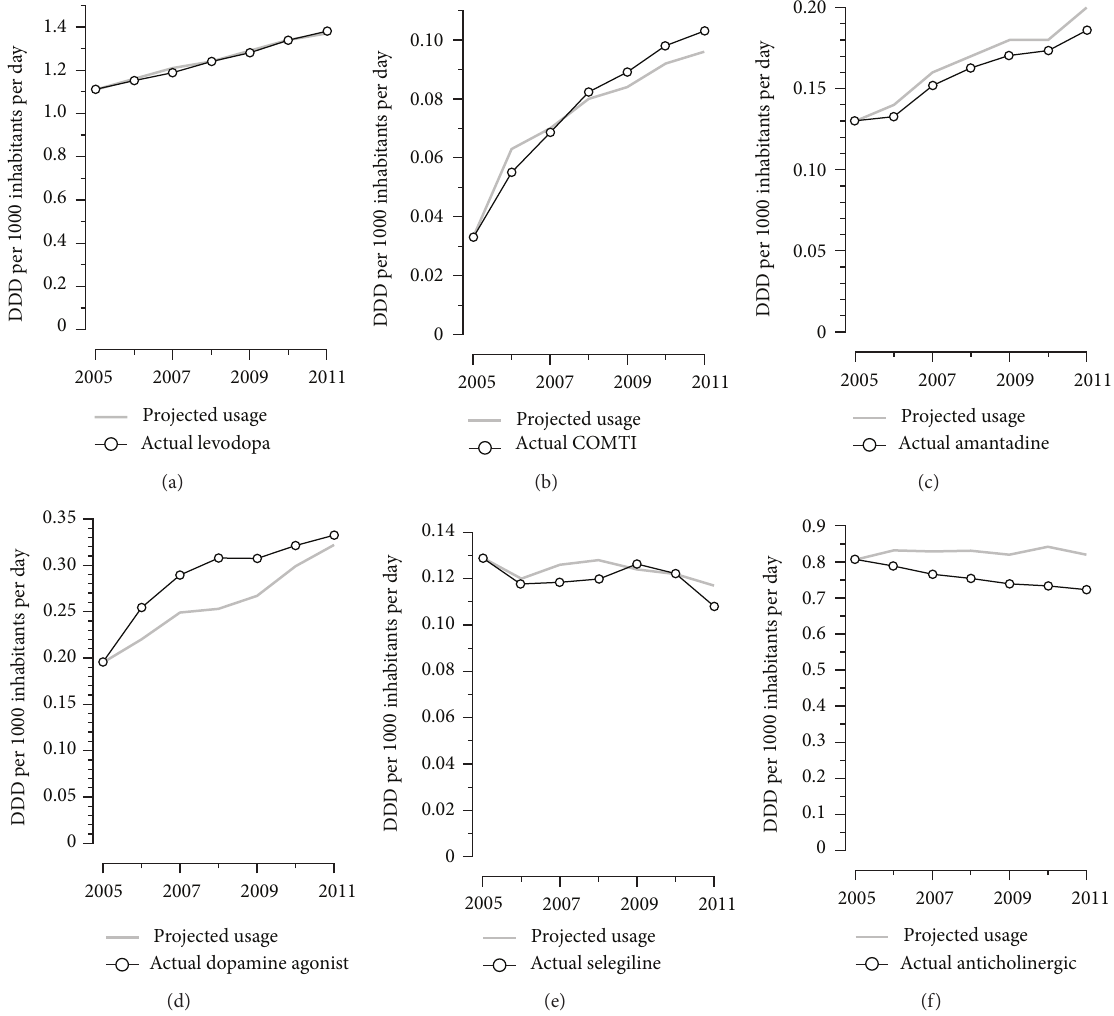
Figure 3: Actual and projected changes in antiparkinsonian agent consumption: 2005–2011. Projected values calculated using the yearly percentage change in the number of people receiving prescriptions for each drug group. (a) Levodopa (L-dopa), (b) catechol-o-methyl transferase inhibitors (COMTI), (c) amantadine, (d) dopamine agonists, (e) selegiline, and (f)